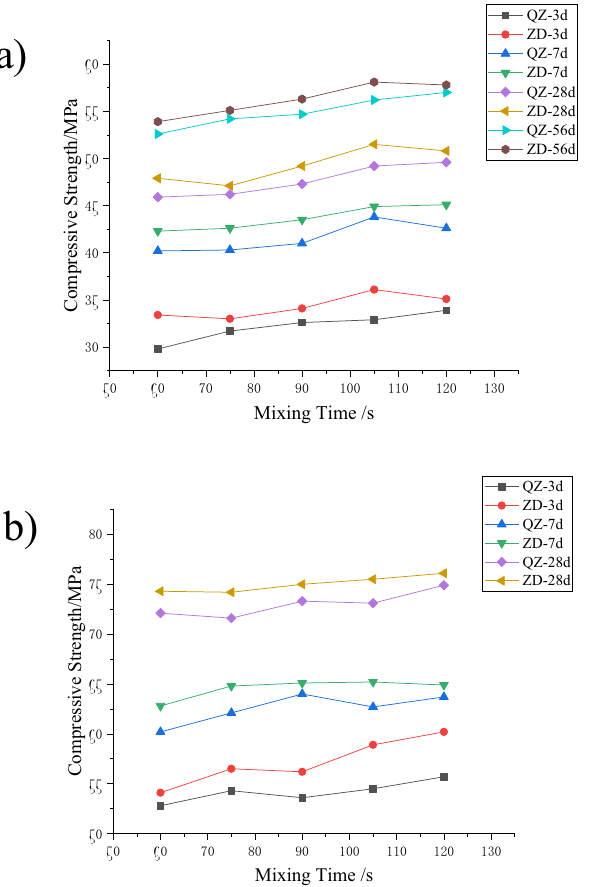
Figure 5: Concrete strength changes with mixing time. ( a ) C40 concrete compressive strength with time and ( b ) C60 compressive strength change curve with